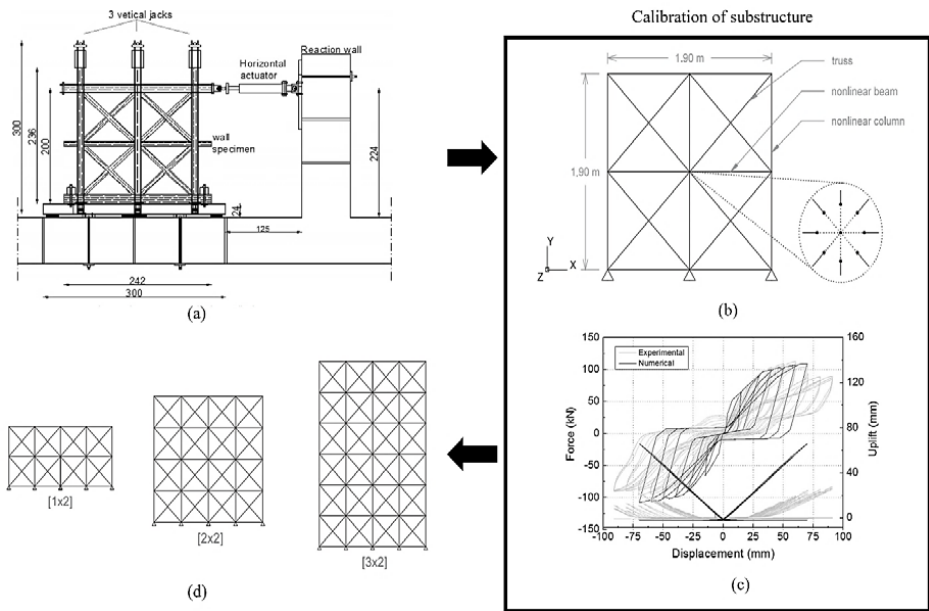
Figure 8. ( a ) Schematic drawing of cyclic test setup of a timber frame wall; ( b ) Numerical model of the wall including the nonlinear springs; ( c ) Calibration of the substructure model based on the hysteresis behaviors of the test results and the numerical model; ( d ) Developing nonlinear models for the buildings with di ff erent configurations. Reprinted from